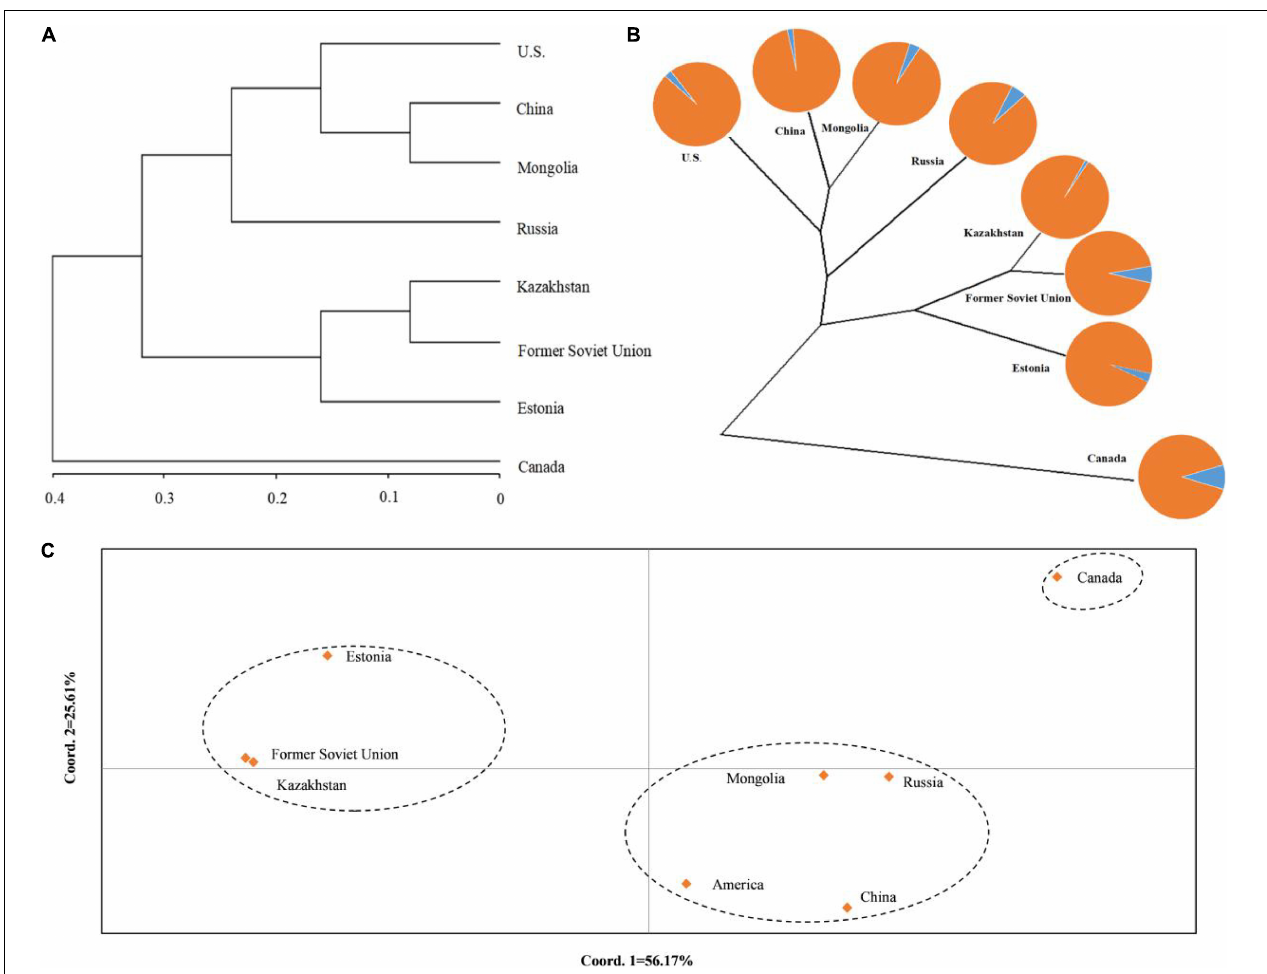
FIGURE 3 | Population structure of eight regions populations of Psathyrostachys juncea . (A) The principal coordinates analysis (PCoA) of eight populations of P. juncea . (B) The unrooted tree based on Nei’s genetic distance for eight P. juncea populations. The pie chart reflects the distribution proportion of individuals of the regions populations in the two groups. (C) UPGMA analysis of eight populations of P. juncea based on Nei’s genetic distance. TABLE 8 | Gene flow ( N m , above diagonal) and genetic differentiation coefficient ( F st , below diagonal) between the eight regions. United